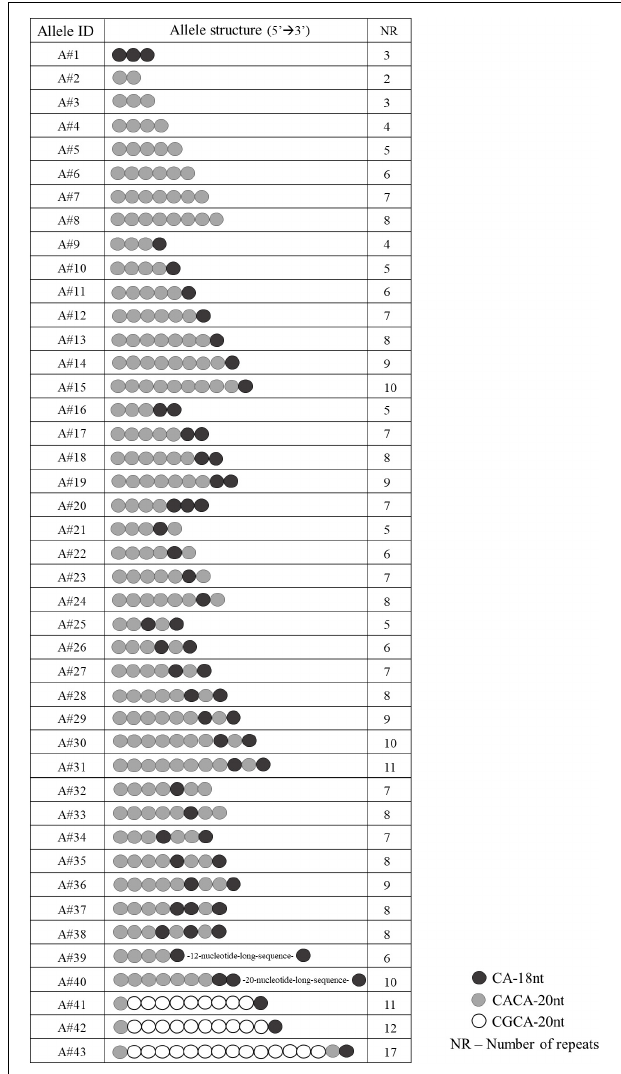
FIGURE 1 | Schematic representation of the 43 allele structures identified in the 380 unaffected individuals.